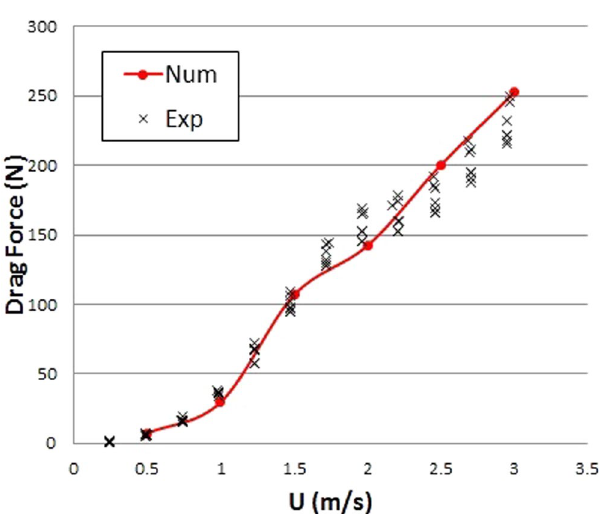
Figure 2. Comparison of the numerical simulated and experimental measured drag forces of the validation